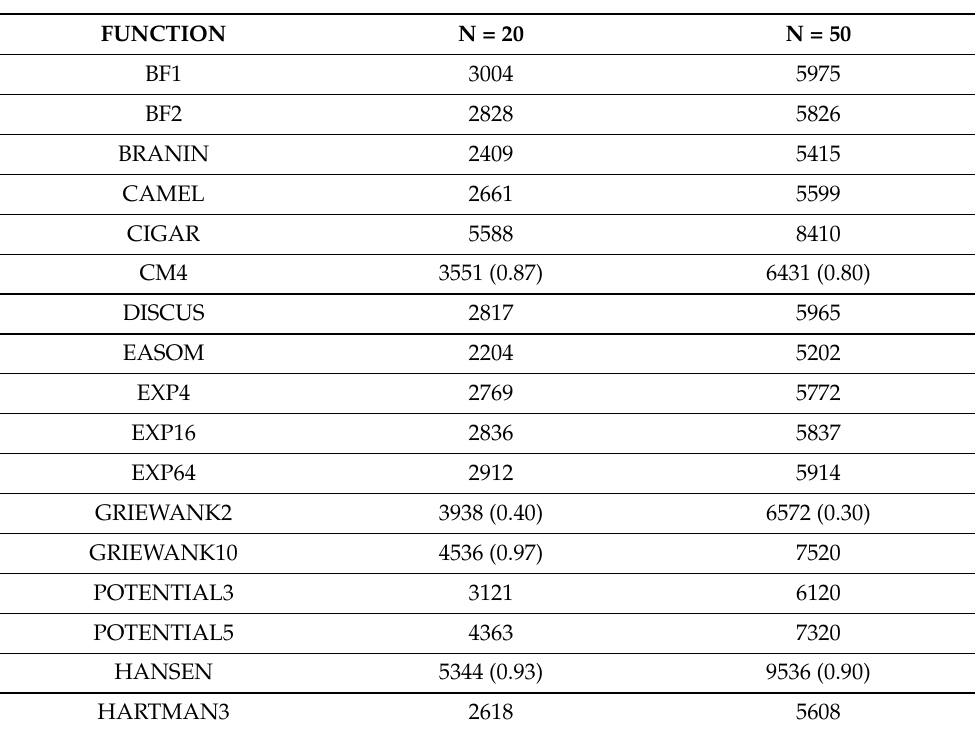
Table 2. Experimental results for the Multistart method, using uniform distribution for the samples as defined in Equation